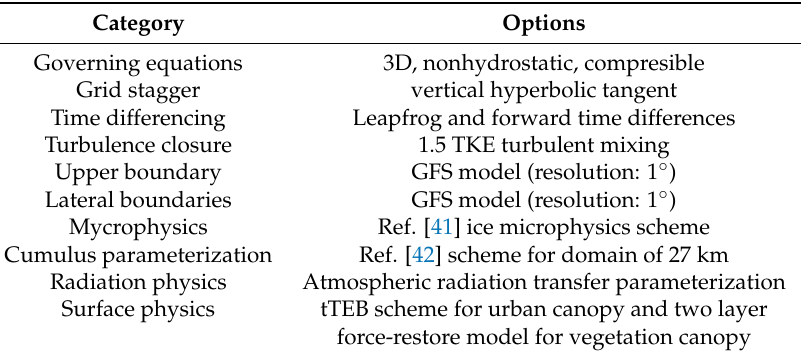
Table 1. Summary of basic model